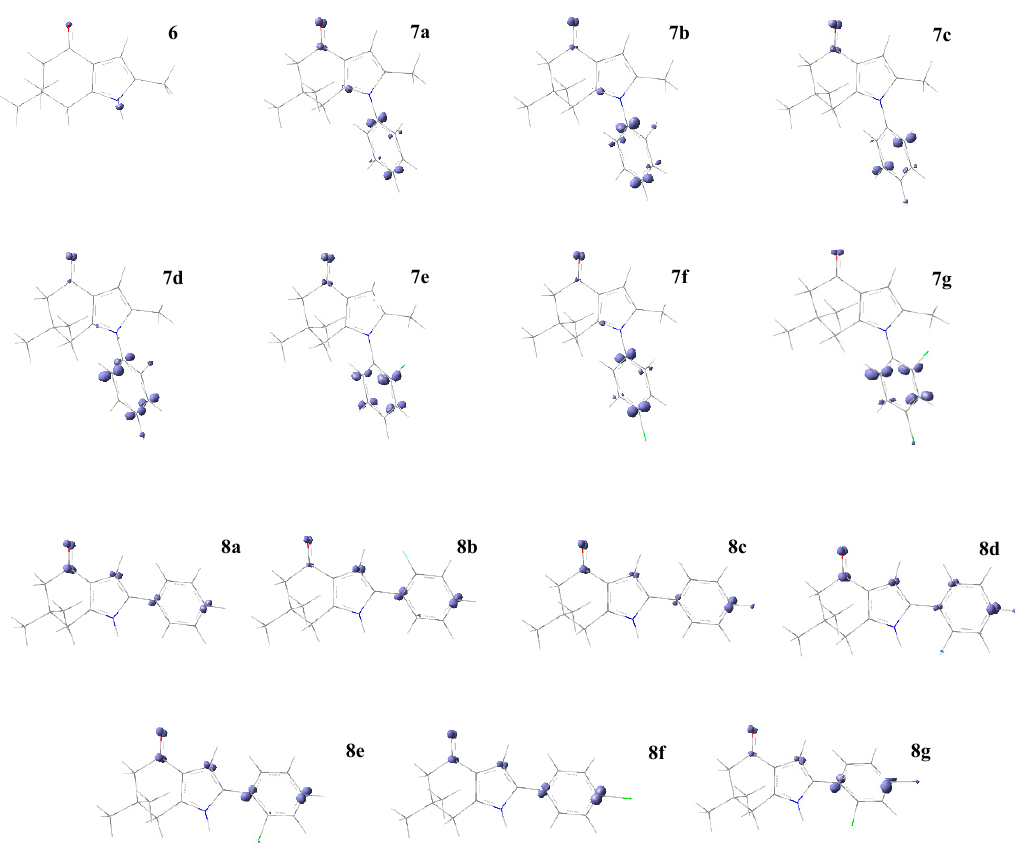
Figure 3. Fukui function isosurface plots for a nucleophilic attack f + ( r ) of series I ( 6 , 7a – g ) and II ( 8a – g ) of compounds. In purple color (positive values) are the favorable sites for a nucleophilic attack; cutting value 0.01 a.u.